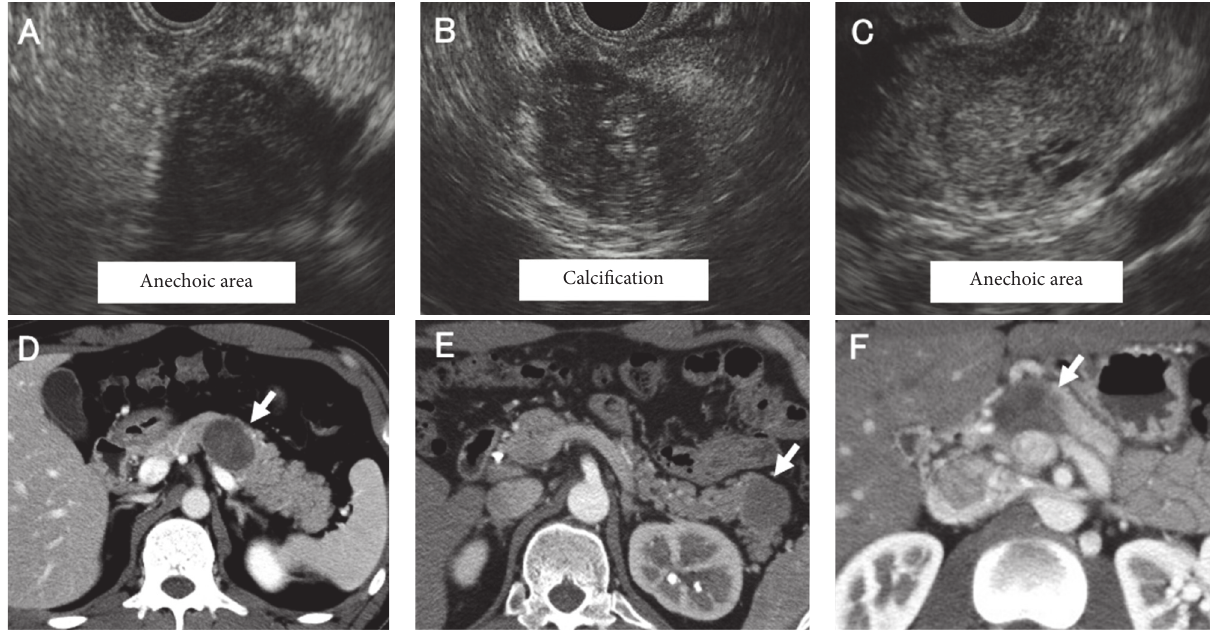
Figure 1: Endoscopicultrasound and computed tomography findings of threeyoung male patients with solid pseudopapillary neoplasms. The endoscopic ultrasound and computed tomography findings of three young male patients with solid pseudopapillary neoplasms are shown. Solid and hypoechoic masses with anechoic areas were observed in (A) Case 1 and (C) Case 3. Internal calcification was observed in (B) Case 2 by endoscopic ultrasound. Computed tomography showed low-density tumors with slight enhancement at the margin in all three